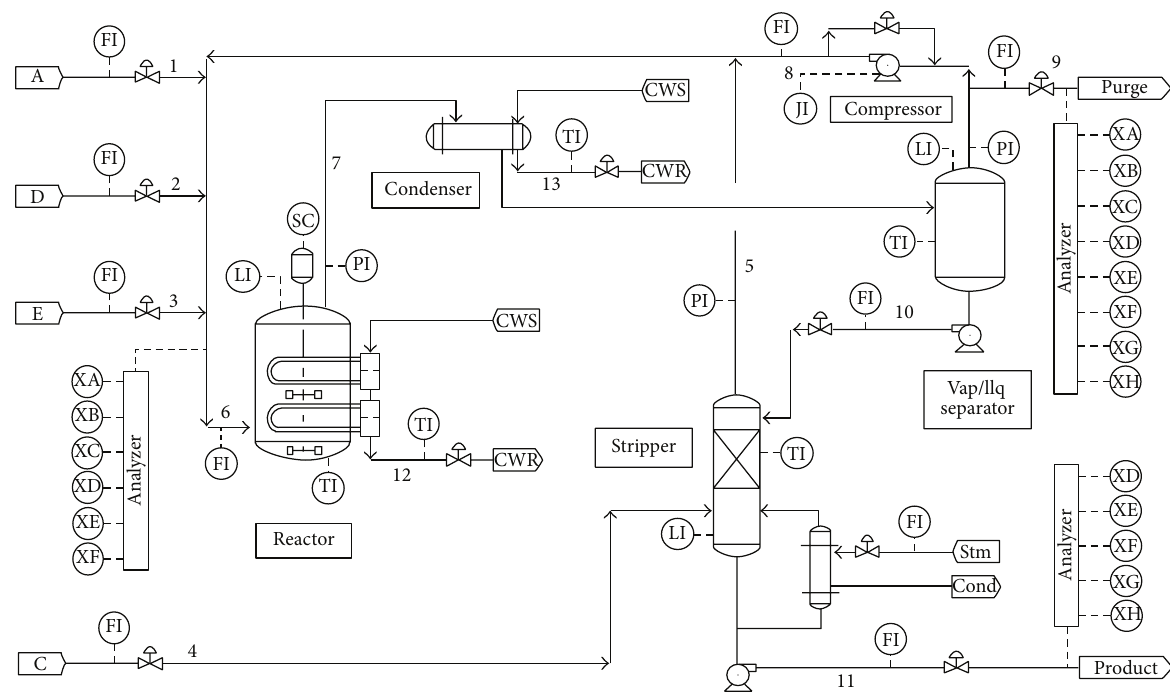
Figure 1: The Tennessee Eastman process.